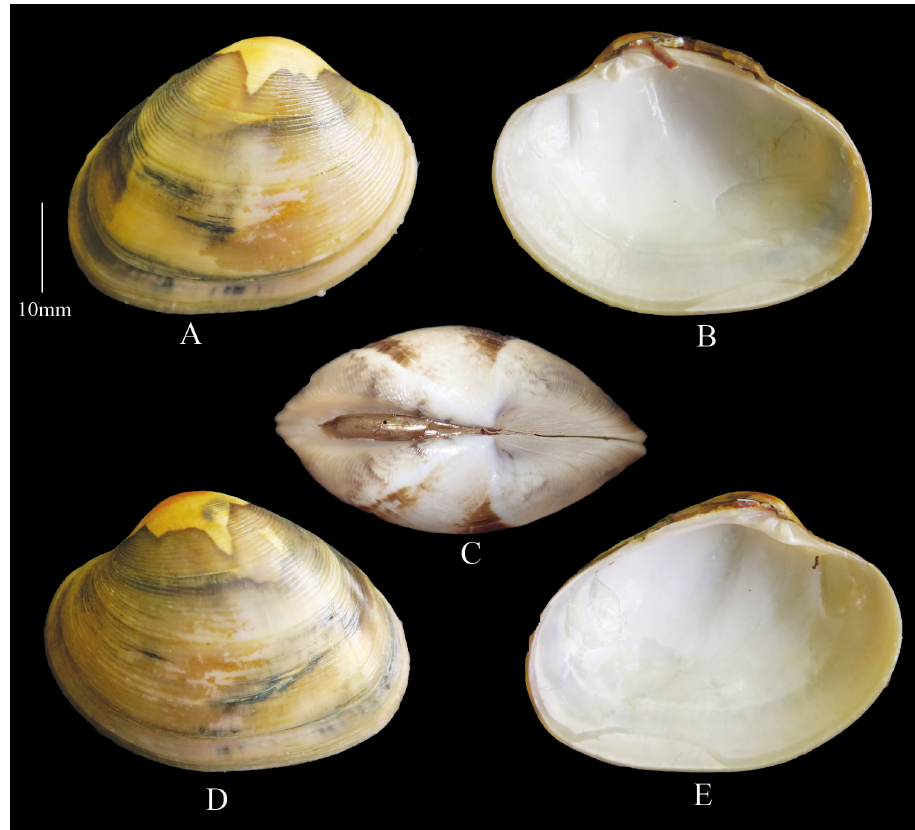
Figure 7. Marcia recens Morphotype 3 A right valve dorsal B right valve ventral C dorsal margin D left valve dorsal E left valve ventral (DABFUK), Ashtamudi Lake, Remarks. The genera Protapes , Paphia, and Paratapes all share the character of the ascending pallial sinus. Paphia and Paratapes differ in outline and sculpture in being elongate, distinctly longer than high, and having a smooth shell. Three species of Protapes are recorded from Indian waters, P. gallus (Gmelin, 1791), P. ziczac (Linnaeus, 1758), and P. monstrosus (Römer, 1870), and all are well illustrated by Huber (2010). Only P. gallus and P. ziczac were collected in this study.